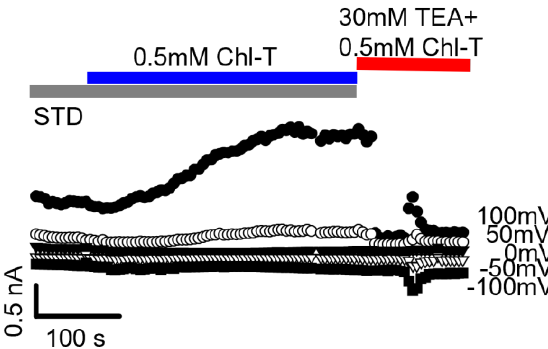
Figure 1. Application of Chl-T activates large outward currents in IGR39 cells, but not in IGR37 cells. ( a ) Left: time course of currents elicited in a typical IGR39 cell during the application of 0.5 mM Chl-T in STD solution, at different potentials from − 100 mV to +100 mV, as indicated. Right: IV relationship in the same IGR39 cell elicited before and after the addition of Chl-T. ( b ) Similar to ( a ), but recorded in a representative IGR37 cell.